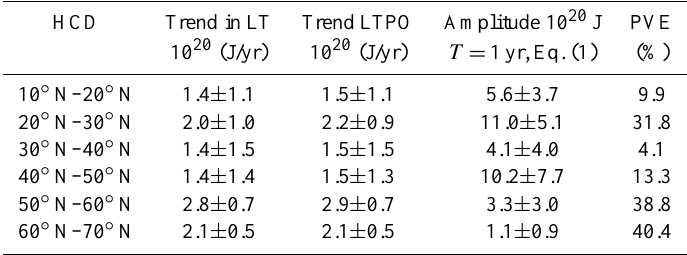
Table 5. HCD at different latitudes; the uncertainty is at the 95% confidence level.